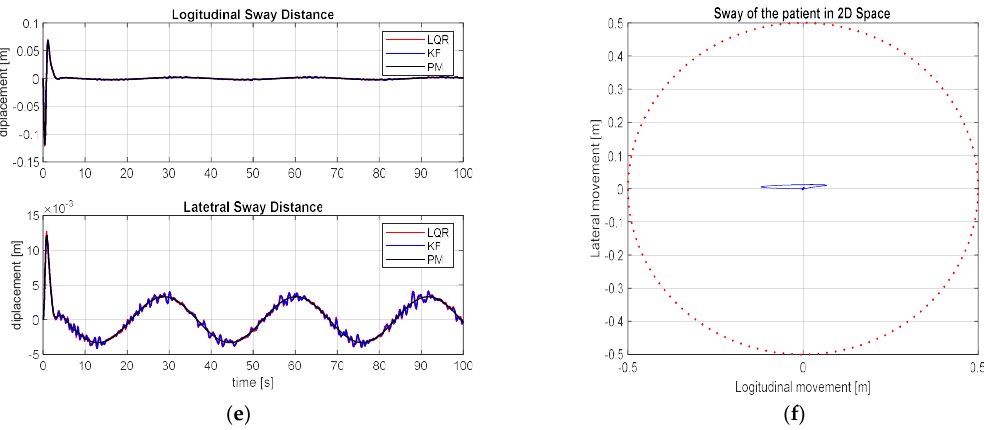
Figure 15. Sinusoidal movement results: Longitudinal and lateral movement. ( a ) Overall view; ( b ) enlarged view, longitudinal and lateral sway angles; ( c ) overall view; ( d ) enlarged, displacement of the patient in 2D plane; ( e ) x and y directional movement; ( f ) patient movement in x-y plane.